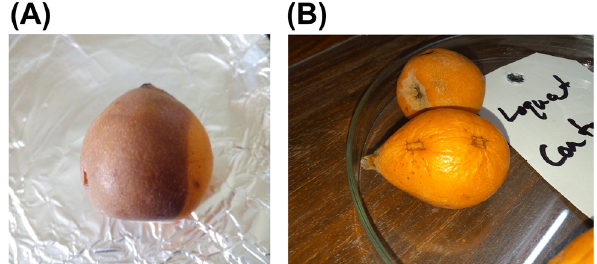
Table  : Accession numbers of the ampli fi ed nucleotide sequences of Alternaria alternata